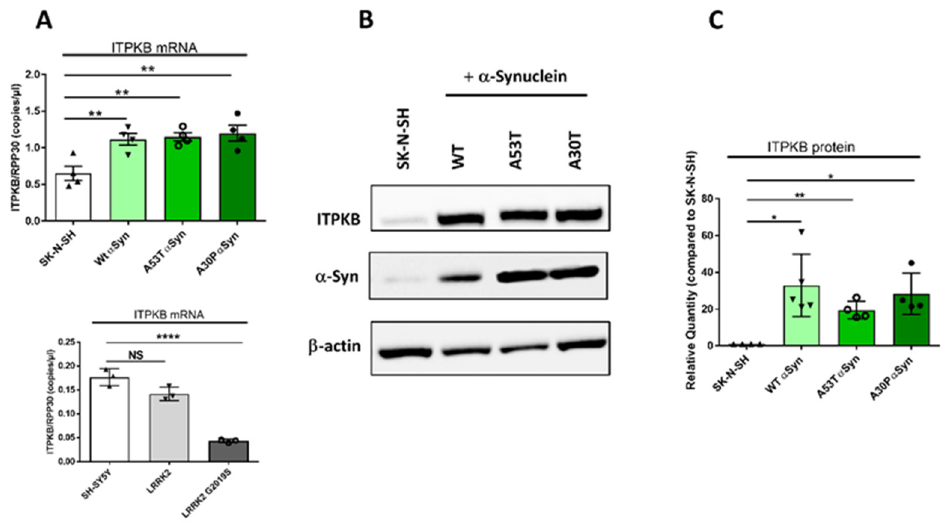
Figure 2. The ITPKB level is increased in SK-N-SH cell lines overexpressing wild-type or mutated A53T or A30P α -synuclein. SK-N-SH cells stably expressing wild-type (wt) or mutated A53T or A30P α -Synuclein were generated in house [24]. ( A ) Bar graphs represent ITPKB mRNA quantification in SK-N-SH cells or SK-N-SH cells overexpressing wild-type α -synuclein (wt) or A53T/A30P isoforms (top); ITPKB mRNA was also quantified in SH-SY5Y cells, and its level was compared with cells overexpressing LRRK2 or LRRK2 G2019S (bottom). N = 3–4 independent experiments were performed ( B ) ITPKB representative Western blot of 4–5 independent experiments. ( C ) Bar graphs represent ITPKB protein quantification in SK-N-SH cells or SK-N-SH cells overexpressing wild-type α -synuclein (wt) or A53T/A30P isoforms. N = 4–5 independent experiments were performed. Means ± SEM are shown. Statistical significance was calculated using a 1-way ANOVA with Bonferroni’s correction for multiple comparisons (ddPCR) or the Student’s t -test with Welch’s correction for unequal distribution (western blot). NS not significant, * p ≤ 0.05, ** p ≤ 0.01. **** p ≤ 0.0001.